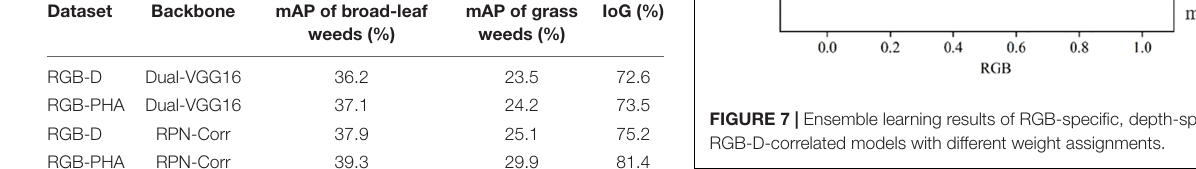
TABLE 3 | Weed detection with multi-modal datasets in multichannel network. Dataset